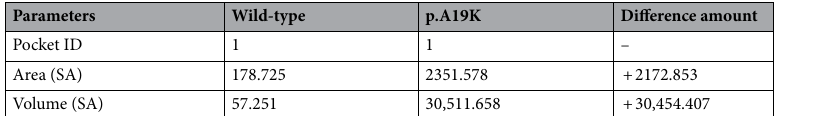
Table 3. Predict the effect of mutation on the binding pocket area “before and after mutation” by the CASTp server. SA shaded area.